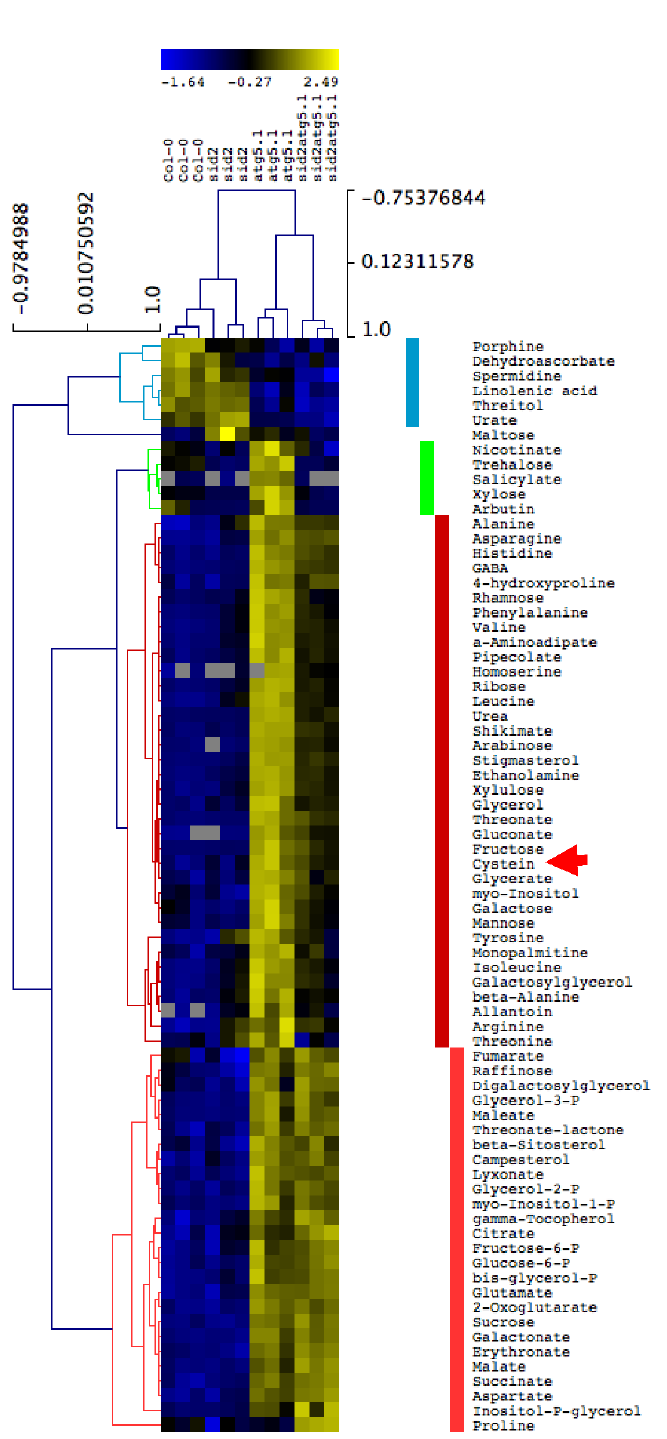
Figure 7. Hierarchic clustering of metabolite relative contents in atg5-1, atg5-1. sid2, sid2 and Col-0 under low S conditions. The metabolite relative contents in the rosettes of atg5, atg5-1. sid2, sid2 and Col-0 plants grown under low sulphate conditions for 60 days were measured using GC-MS. An ANOVA was performed to identify metabolites significantly modified by genotype. The hierarchic clustering of significant metabolites was performed MEV4. The clusters show metabolites less abundant in atg5-1 and atg5-1.sid2 relative to Col-0 and sid2, respectively (blue), more abundant in atg5-1 and atg5-1.sid2 relative to Col-0 and sid2, respectively (red), and more abundant in atg5-1 only by comparison with the three other genotypes (green). The red arrow indicates the position of cysteine. Three biological repeats are shown for each